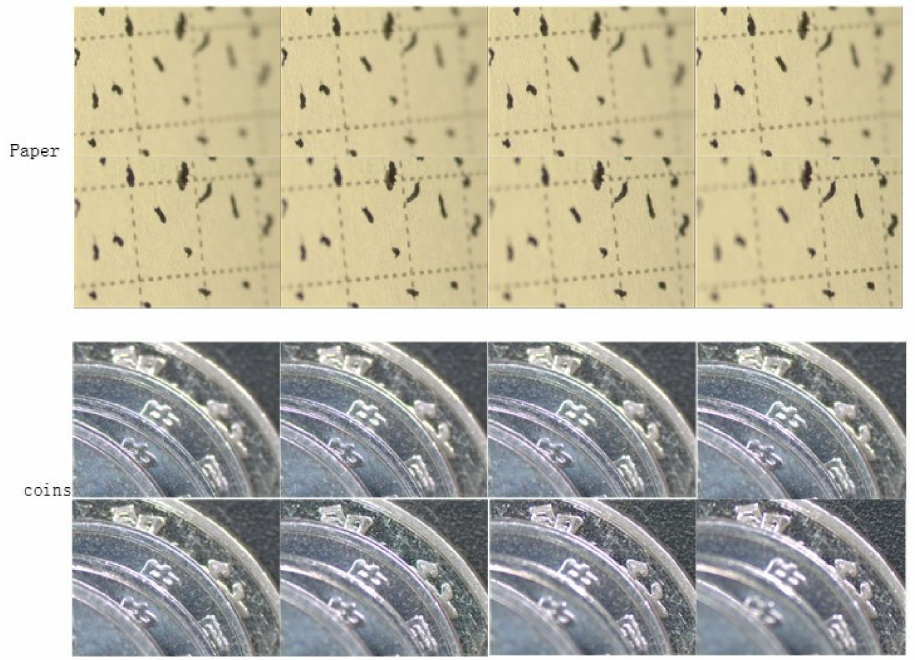
Figure 4. Registration of two groups of partial defocusing.